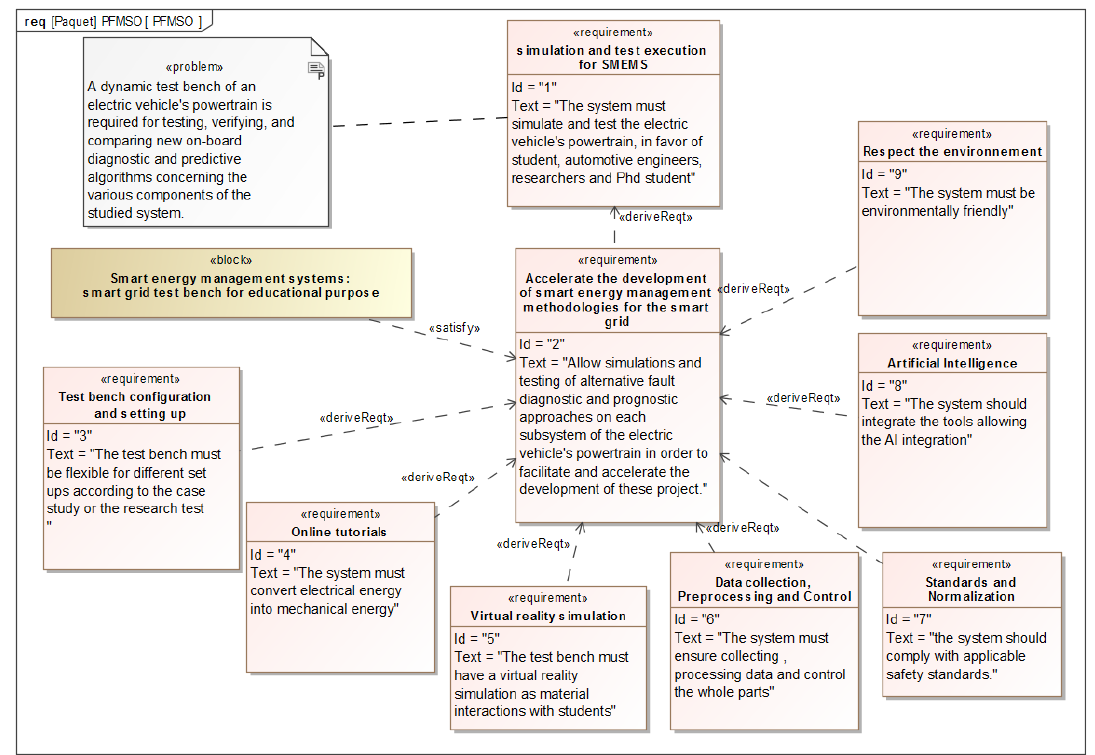
Figure 3. The PFMSO requirement diagram (major needs).